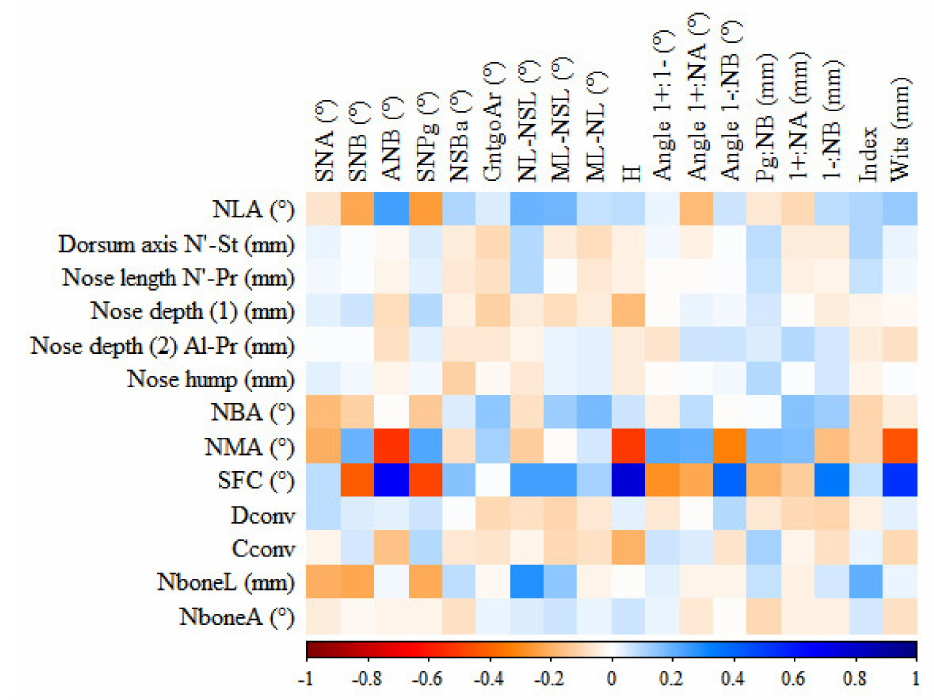
Figure 2. Correlation matrix for nasal and cephalometric